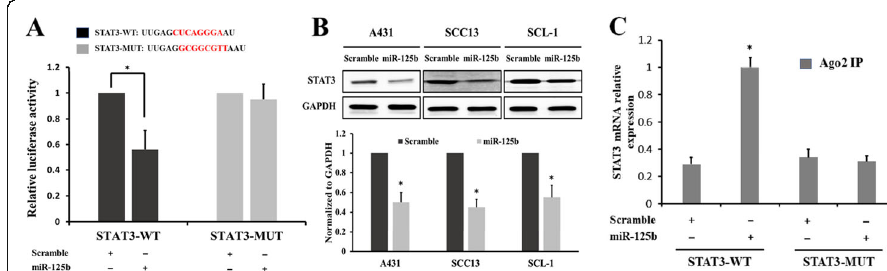
Fig. 2 STAT3 is a direct target of miR-125b. a The binding sequence for miR-125b in the 3 ′ -UTR of STAT3 and the mutations are indicated in red. The binding relationship between miR-125b and STAT3 in SCC-13 cells (an CSCC cell line) was analyzed using the dual-luciferase system. b Western blotting was used to determine STAT3 protein expression in A431, SCC13 and SCL1 cells transfected with the miR-125b mimic or scrambled control. c Immunoprecipitation – quantitative PCR was used to evaluate the direct interaction between miR-125b and STAT3. * p < 0.05 in comparison with scramble control